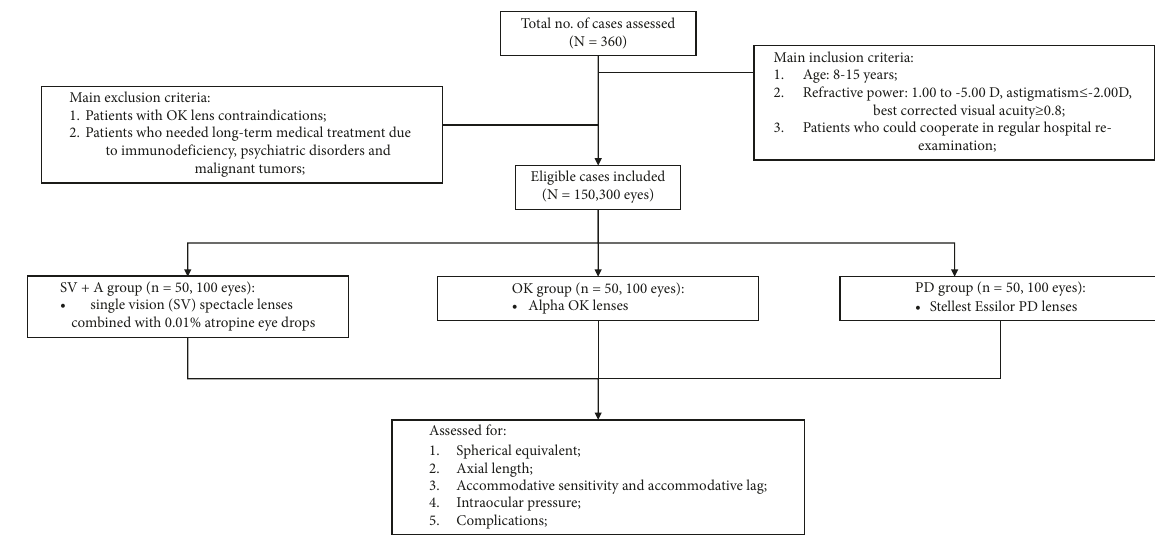
Figure 1: Flowchart of the study